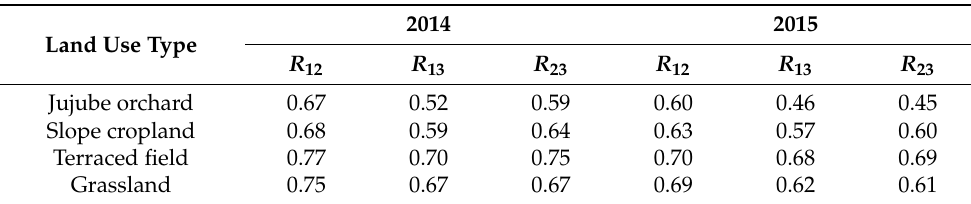
Table 2. Grey relational grade of soil water in different layers under different land uses throughout the growing